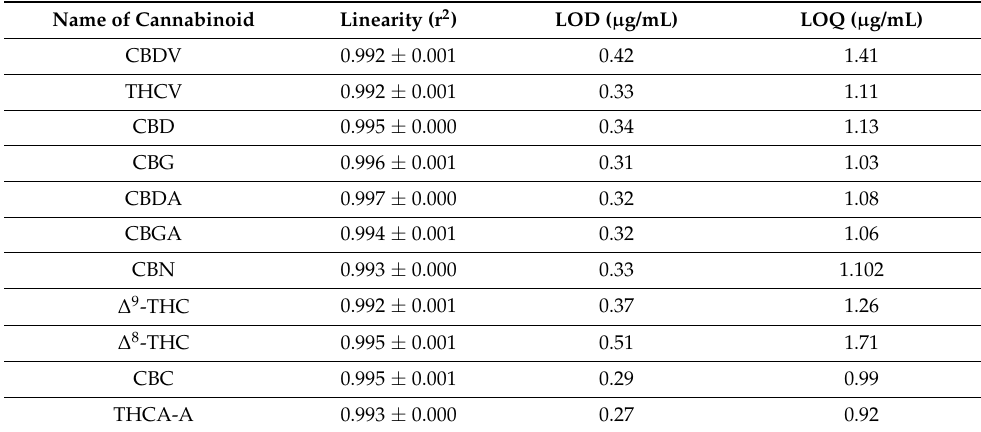
Table 4. Linearity, the limit of detection (LOD), and limit of quantitation (LOQ).